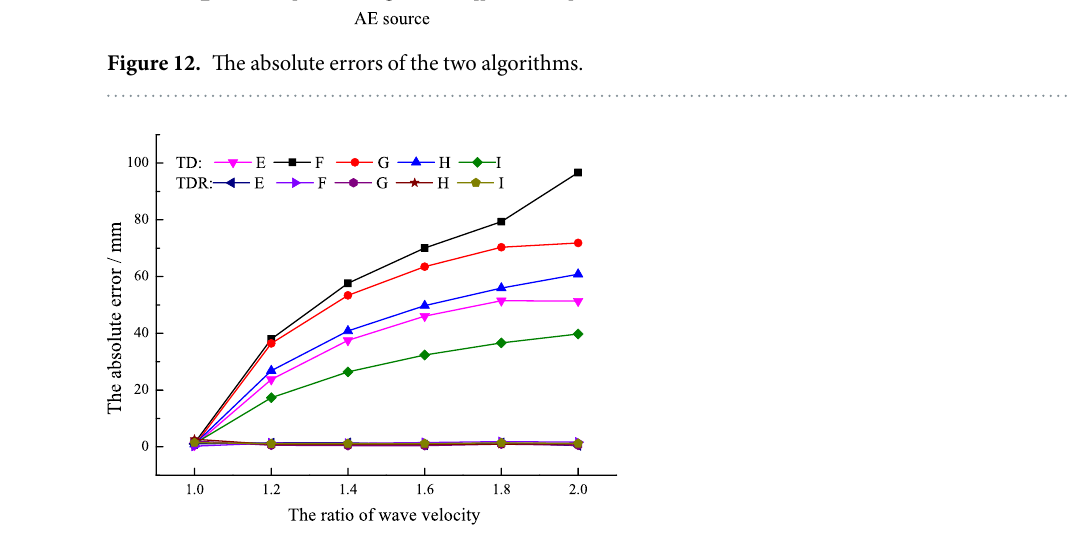
Figure 13. The dependency level of the location results on wave velocity